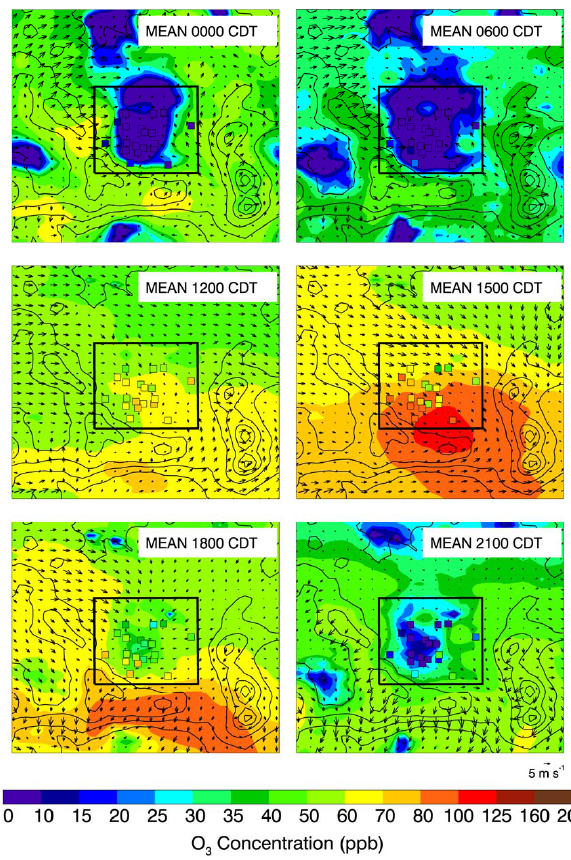
Fig. 6. Ensemble mean (color) of the surface [O 3 ] (ppb) distri- butions along with the ensemble mean winds valid at 00:00CDT, 06:00CDT, 12:00CDT, 15:00CDT, 18:00CDT, and 21:00CDT of the CNTL ensemble simulations (3 March 2006). The colored squares denote the ozone measurements from the RAMA sites. In- ner box denotes the domain used for Fig. 7. Fig. 7. Ensemble mean (black arrows) of the surface winds along